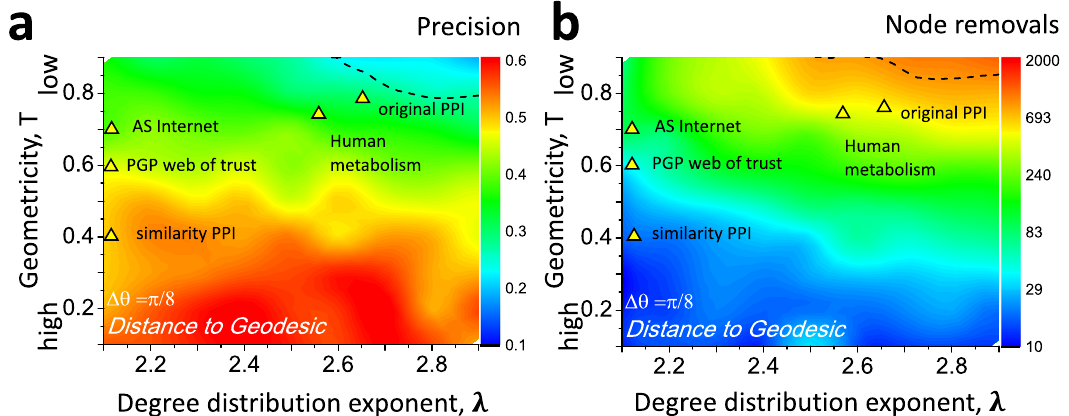
Fig. 3 | The accuracy of nearly shortest path fi nding in synthetic networks incomplete synthetic networks. Synthetic networks are constructed as Random Hyperbolic Graphs (RHGs) of N =5, 000 nodes, average degree 〈 k 〉 =10, and vari- abledegreedistribution, λ ∈ (2,3),andgeometricity T ∈ (0,1)parameters.Afterthe construction of each network, we remove each of its links with probability p =0.5.